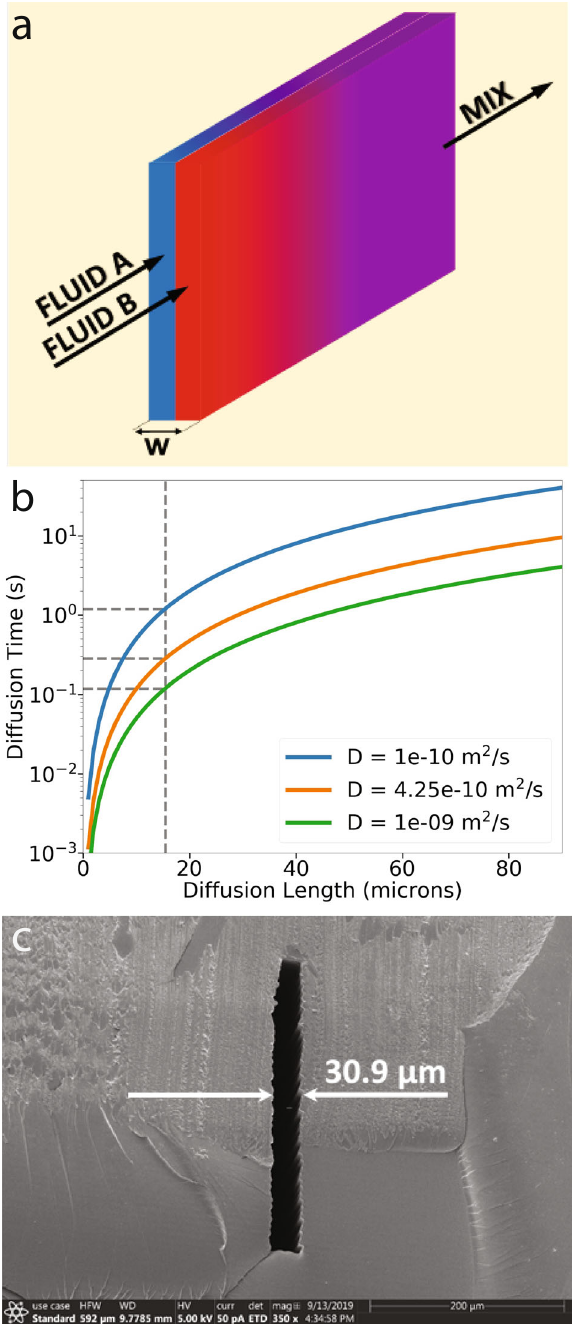
Fig. 4 Fast diffusion mixing. a Two thin fl uid sheets in a narrow vertical channel. b Diffusion time for example molecules over a 15 μ m diffusion length in an aqueous solution. D is the diffusion coef fi cient. Blue = 30 kDa protein, Orange = fl uorescein, Green = dissolved gas molecules. c Cross- section scanning electron microscope (SEM) image of narrow 3D printed diffusion mixing